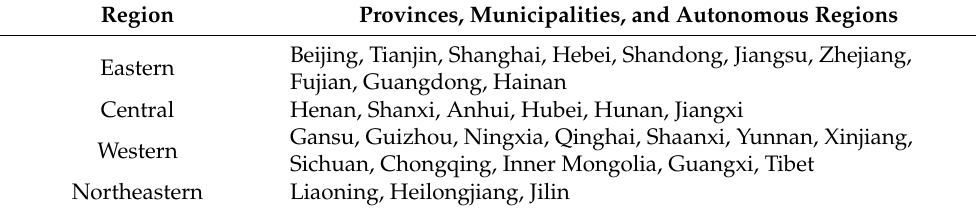
Table 1. Regional division in China. Region Provinces, Municipalities, and Autonomous Regions Eastern